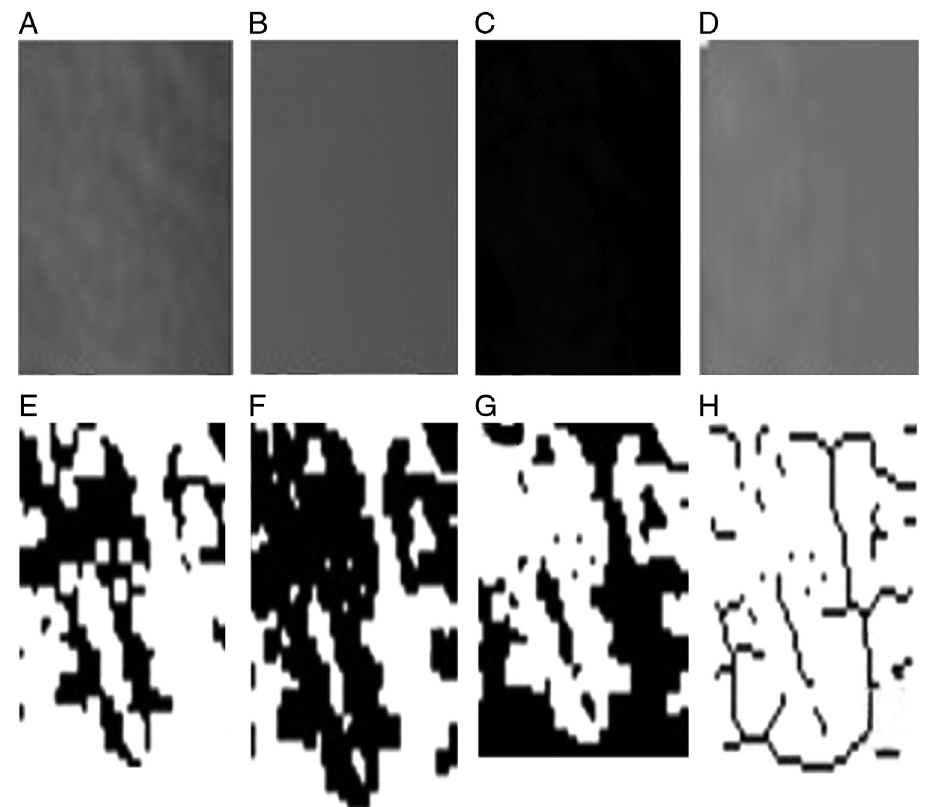
Figure 1. Steps of fractal dimension analysis. A. Cropped and duplicated region of interest. B. Gaussian blur. C. Subtracted blurred image from the original image. D. Addition of a gray value of 128 to each pixel location. E. Erosion. F. Dilatation. G. Inversion. H.